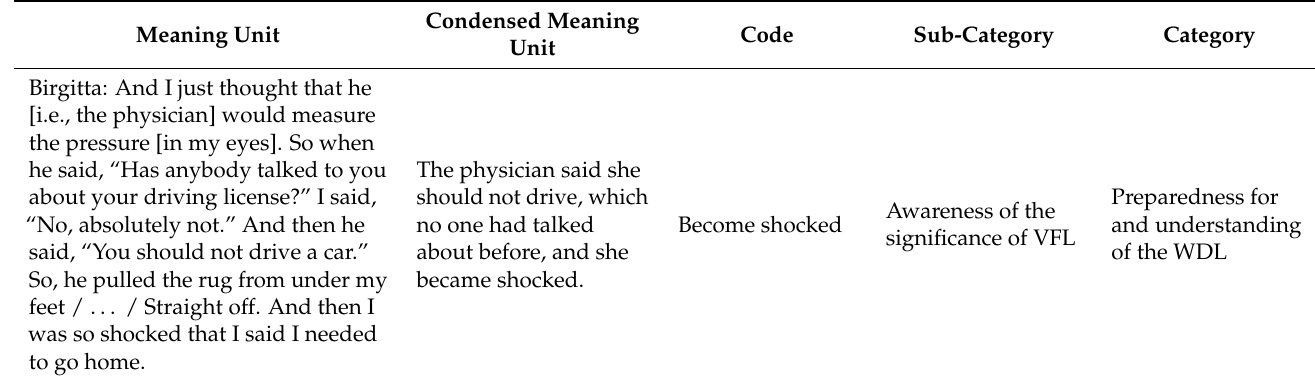
Table 2. Examples of steps in the analytical process (Graneheim and Lundman 2004).